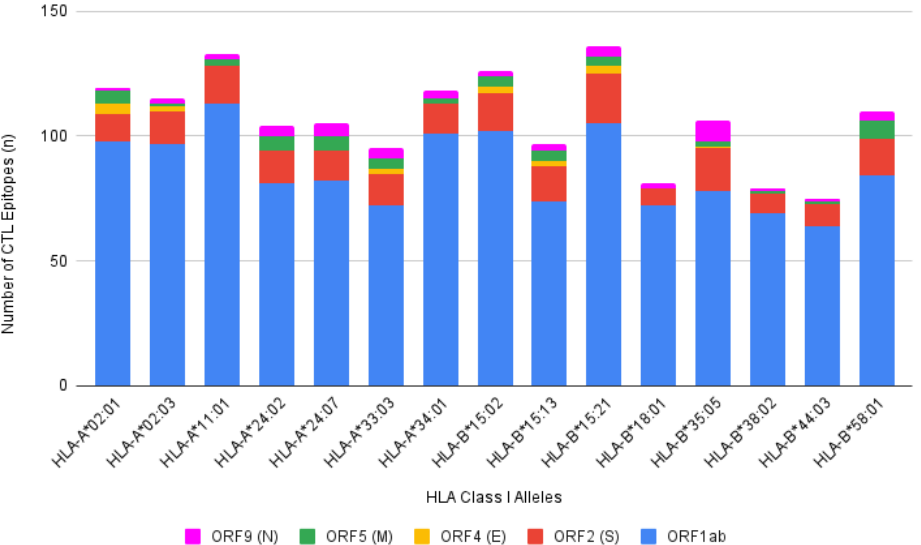
Figure 2. Number of predicted CTL epitopes with %Rank less than 1% from SARS-CoV-2 proteins (ORF1ab, ORF2 (S), ORF4 (E), ORF5 (M), and ORF9 (N)) with previously identified HLA Class I alleles. A total of 1599 bindings were predicted through NetCTLpan 1.1 with the highest binding recorded by HLA-B*15:21 and the least by HLA-B*44:03, 136 and 75, respectively. ORF1ab is represented by blue color; ORF2 (S) is represented by red color; ORF4 (E) is represented by yellow color; ORF5 (M) is represented by green color; ORF9 (N) is represented by pink color.